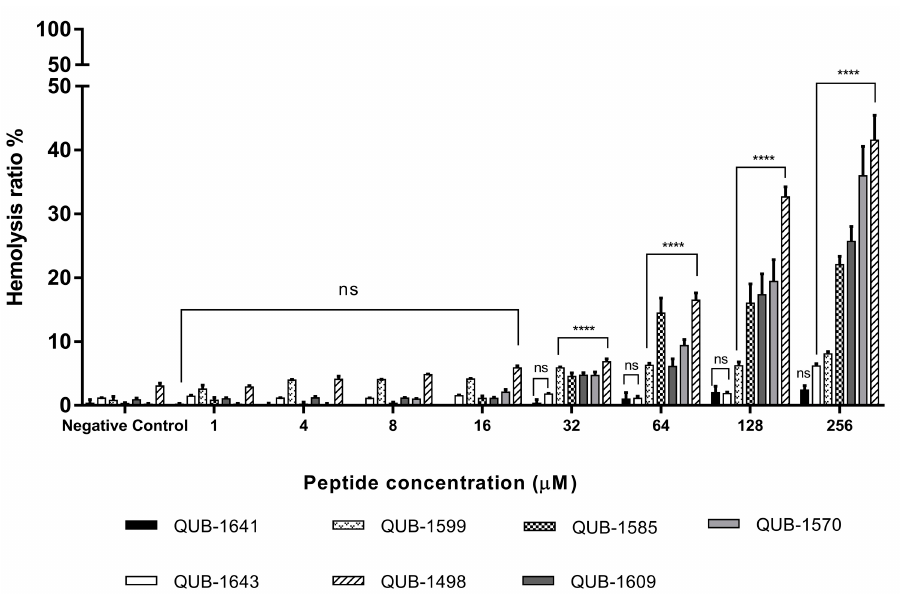
Figure 10. The hemolytic activities of kassporin-KS1 (QUB-1641) and its analogues. Triton X-100 was the positive control. PBS solution was the negative control. The results of the peptide sample group and the negative control group were compared by using two-way ANOVA. The significance level was: ****= p < 0.0001, ns= no significant difference. The error bars indicated the ± SEM of five replicates.